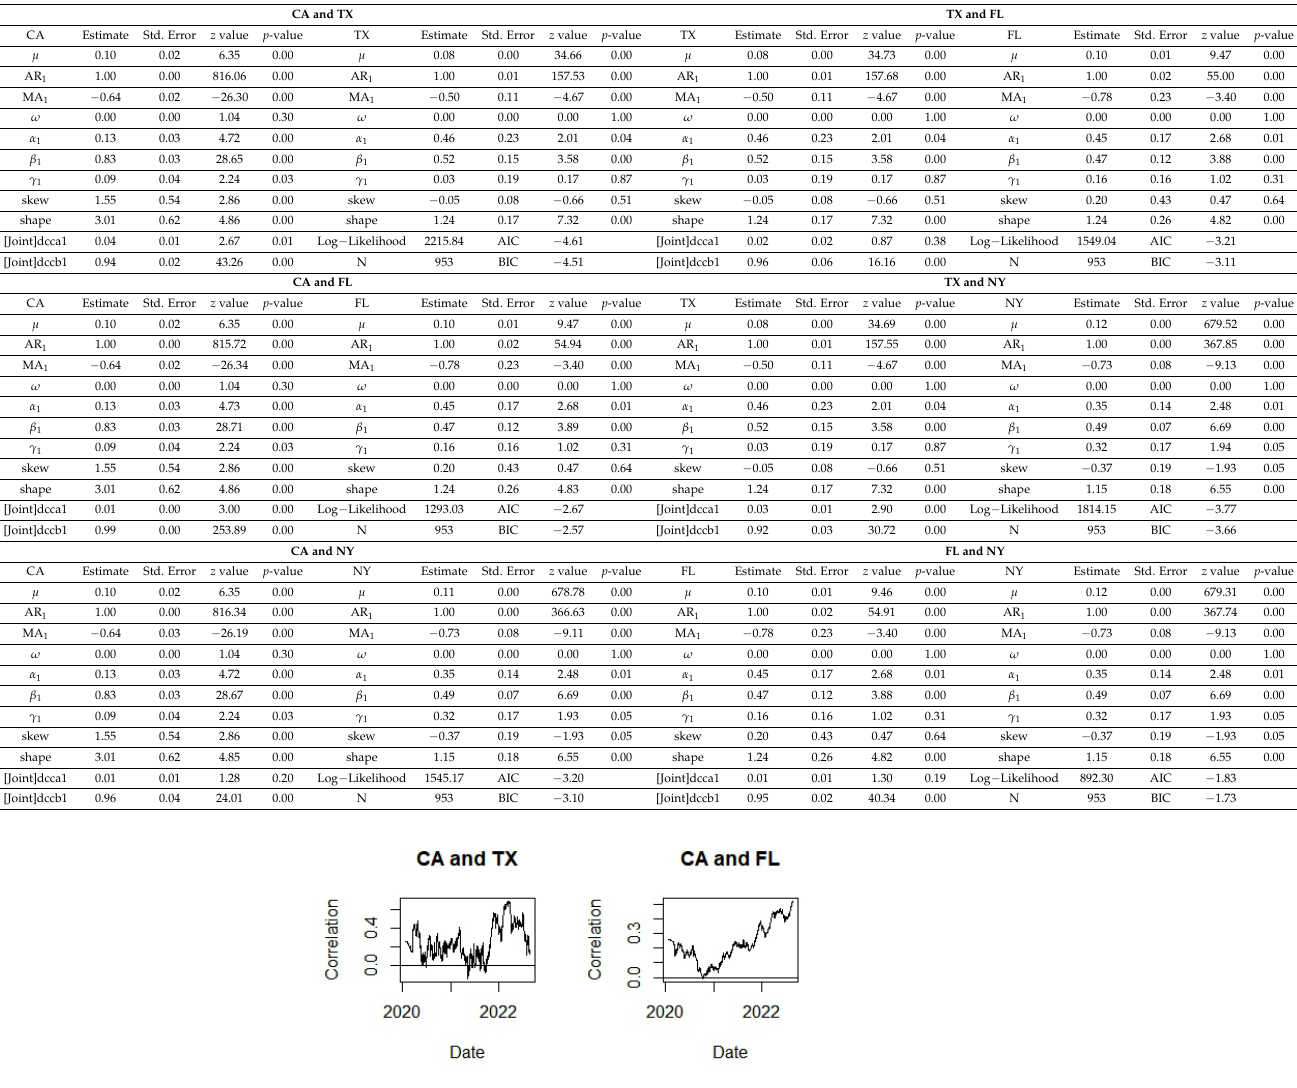
Table 5. Copula-DCC Models.